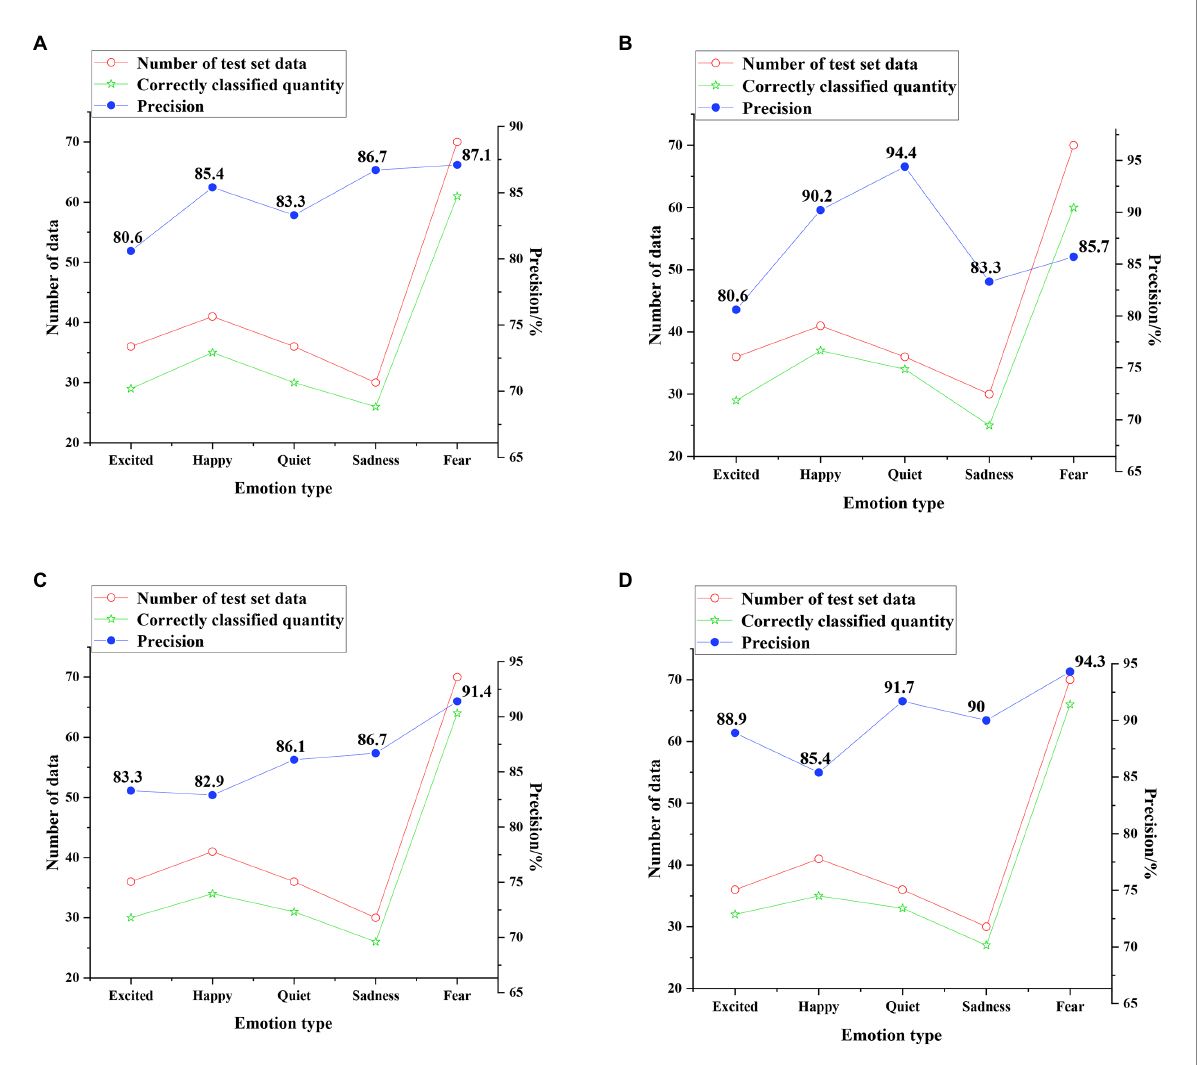
FIGURE 15 Test results on the enhanced dataset (A) SVM classification results; (B) CNN classification results; (C) unidirectional LSTM classification results; and (D) Bi LSTM classification